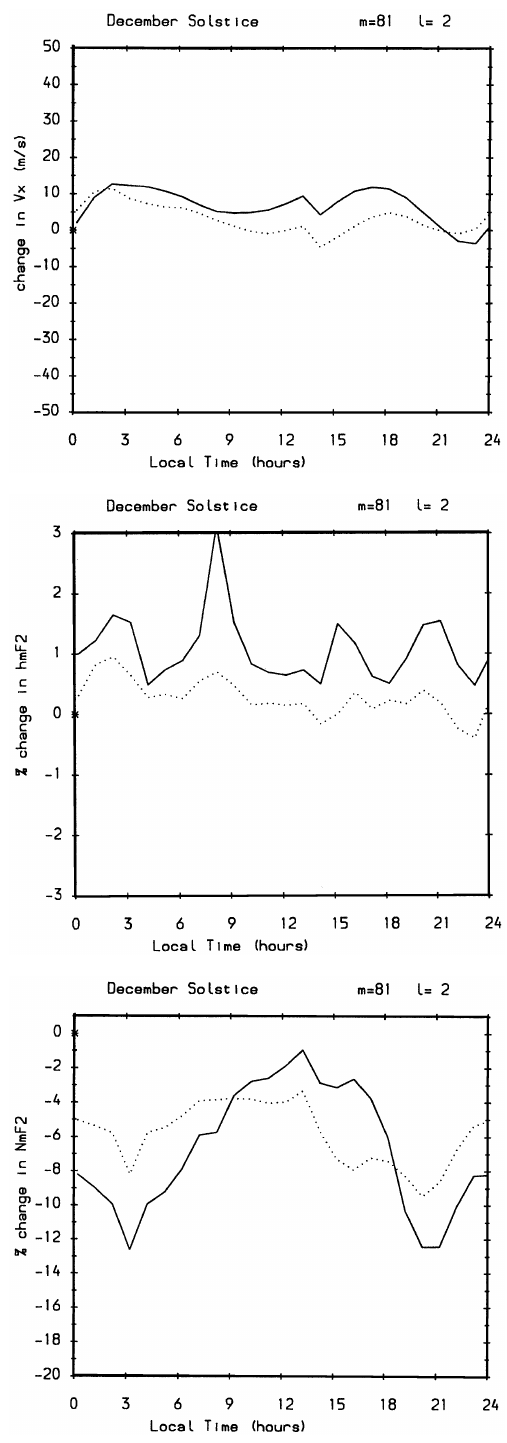
Fig. 7. (a) Change in the meridional wind velocity ( V x ) as a func- tion of local time (positive equatorward). (b) Change in the height of the peak concentration of the F-region ( hm F2); (c) Change in the peak electron concentration of the F-region (NmF2). In each panel, the solid (broken) lines represent the change from (cid:15) 6 = 1 to (cid:15) 6 = 1 . 4 ( (cid:15) 6 = 1 .